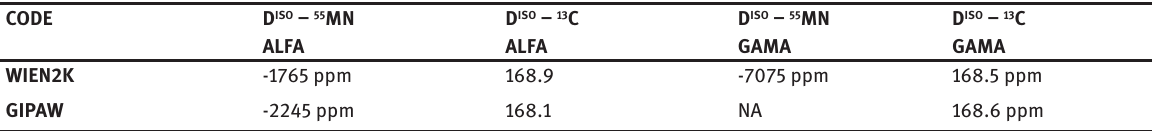
Table 5: Wien2k and GIPAW NMR data.